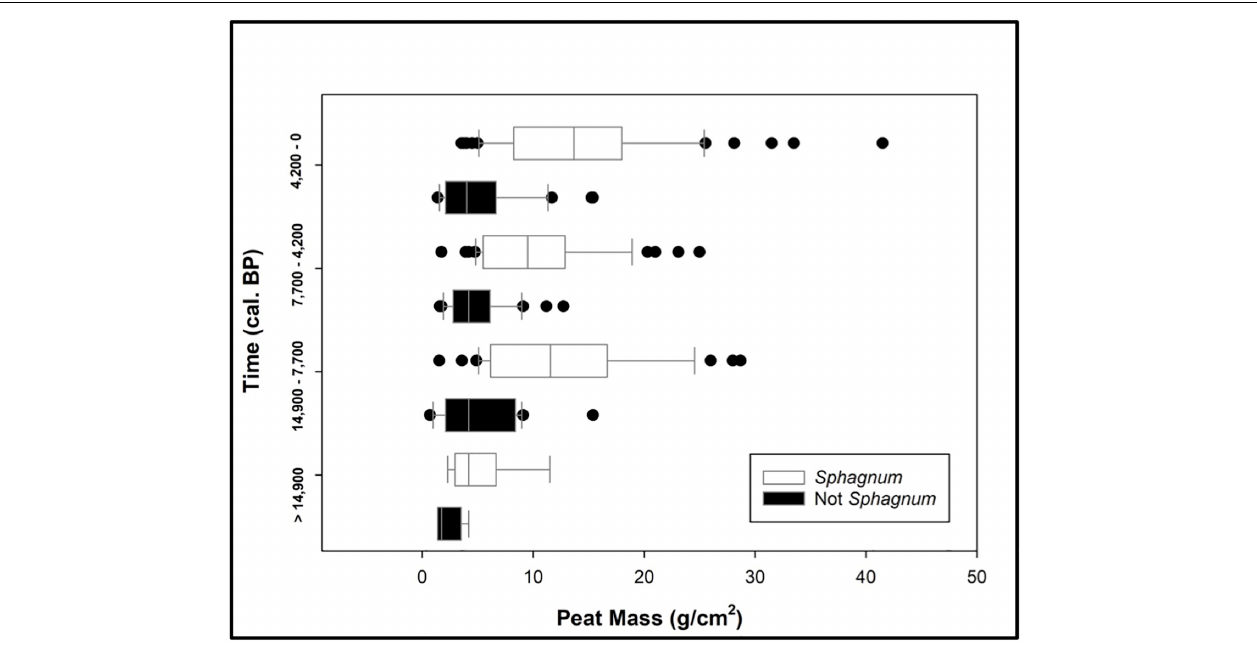
FIGURE 5 | A comparative analysis of Sphagnum vs. non- Sphagnum peat masses over time. The time periods are dictated by three tephra layers: Reclus I (14,900 cal. yr BP), Hudson I (7700 cal. yr BP), and Burney II (4200 cal. yr BP). Sphagnum and non- Sphagnum peat masses are statistically different for every time period (Tukey’s HSD: p < 0.0001), except prior to 14,900 cal. yr BP.